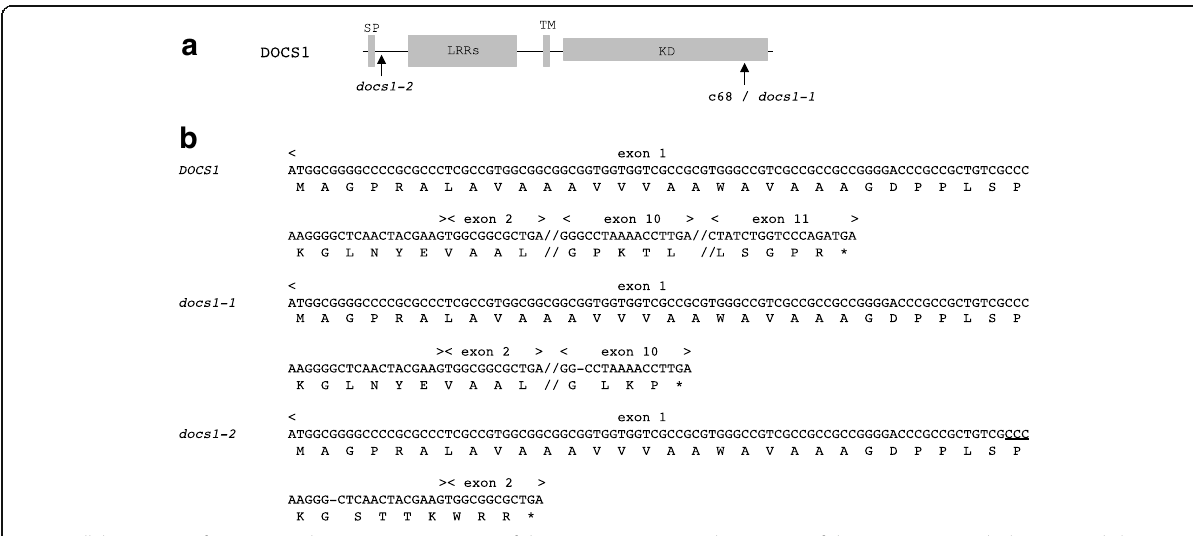
Fig. 1 Allelic variants of DOCS1 . a Schematic representation of the DOCS1 receptor with positions of the CRISPR targeted ( docs1 – 2 ) and docs1 – 1 mutations. b The nucleotide and protein sequences of the DOCS1 gene and the two allelic variants, docs1 – 1 and docs1 – 2 , are represented. The new allelic variant docs1 – 2 presents a deletion of one nucleotide 95 pb after the START codon, at the end of the 1st exon. The PAM sequence located 3 nucleotides upstream of the double strand break site is underlined. The deletion of one nucleotide in docs1 – 1 is located in the 10th exon. Bars represent nucleotide